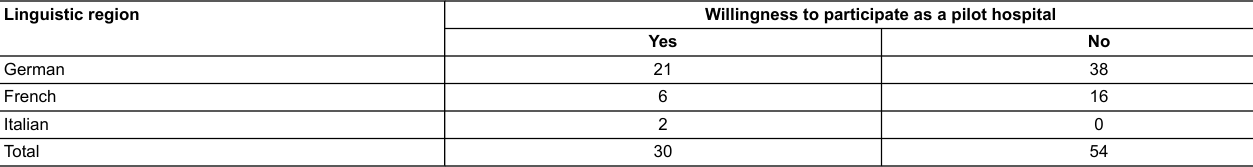
Table S4: Willingness to participate as a pilot hospital by linguistic region. Linguistic